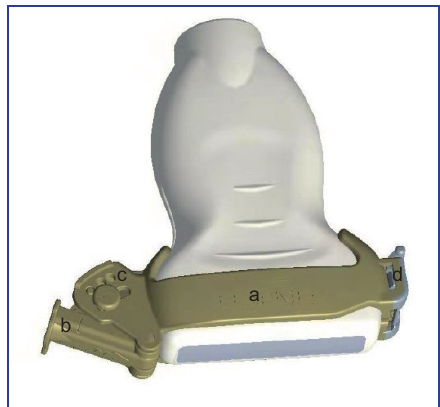
Figure 10 Needle-guide (i.e., puncture rack) and probe. a, Needle-guide body; b, Needle guiding tube; c, Puncture angle adjusting axis; d, Fixing lock of the needle-guide, the rack can be removed from the probe after releasing the lock.; e, Probe.